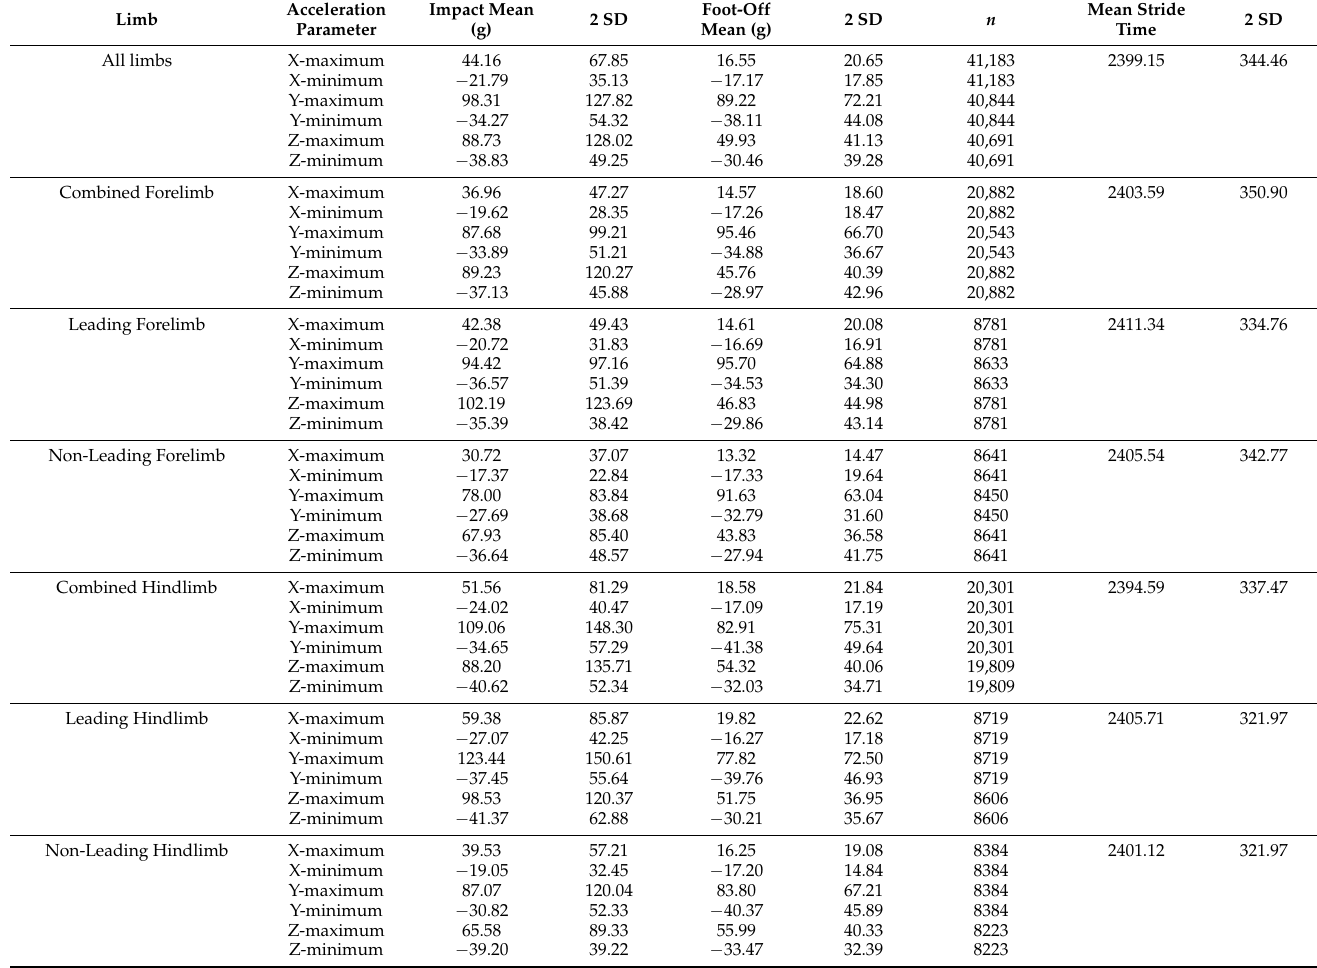
Table 2. Summary of peak accelerations at impact and foot-off across the x, y and z acceleration axes for each of the limb types. Please note that, alongside the leading and non-leading limb data, “mixed lead” runs were included in the forelimb and hindlimb data outputs listed as